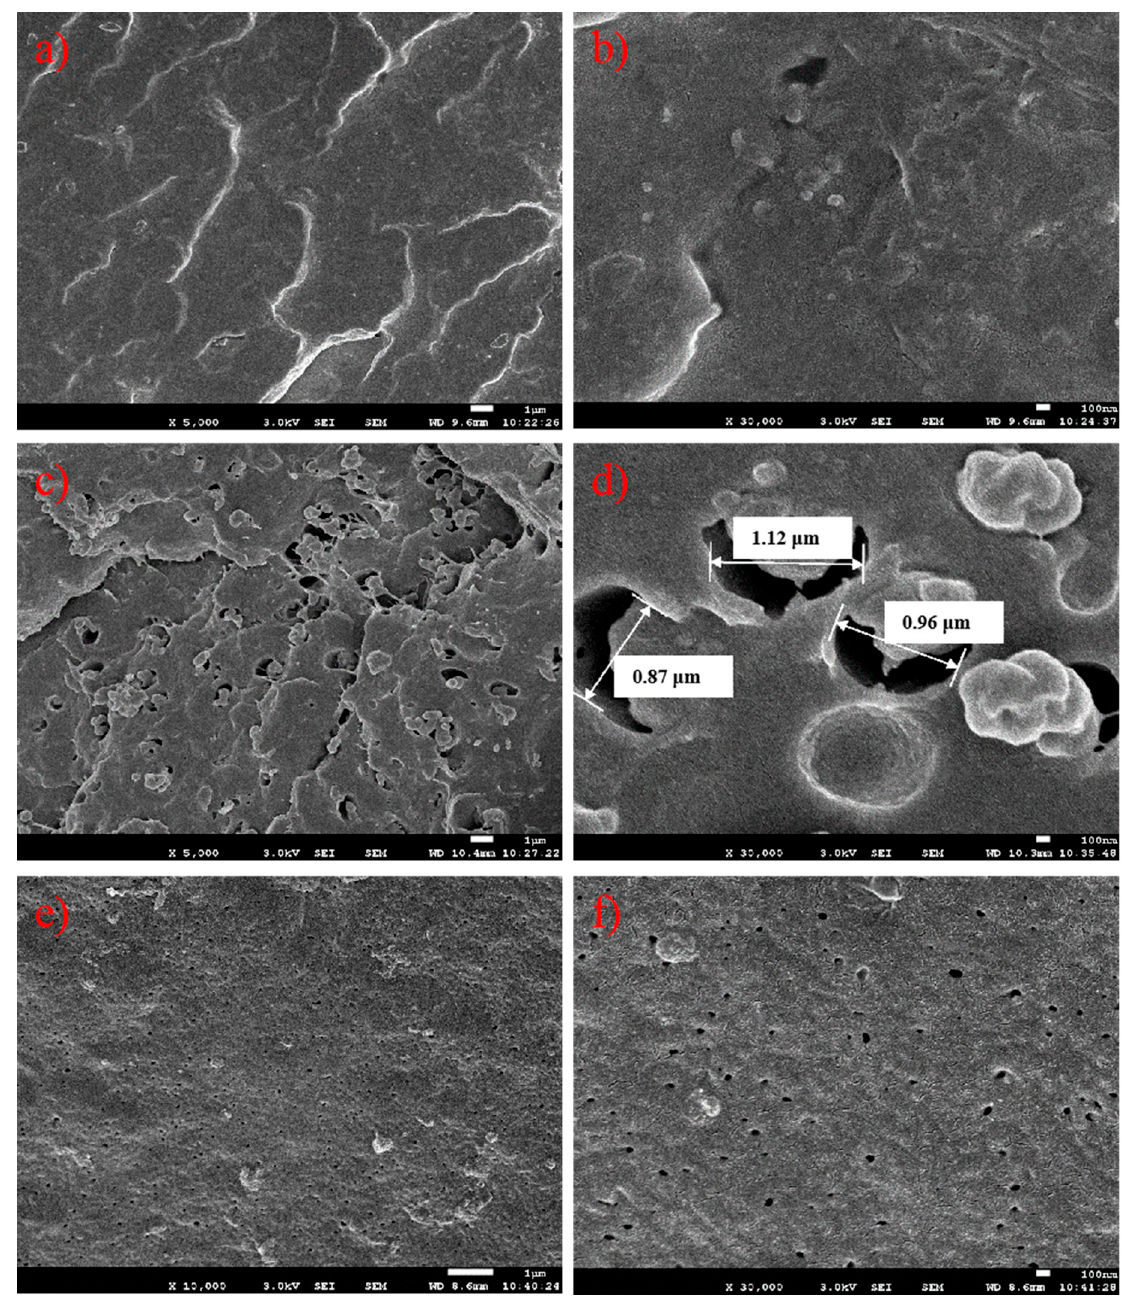
Figure 10. Scanning electron microscopy images of the three PP samples. a ) and b ) PP-1; c ) and d ) PP-2; e ) and f ) PP-3.